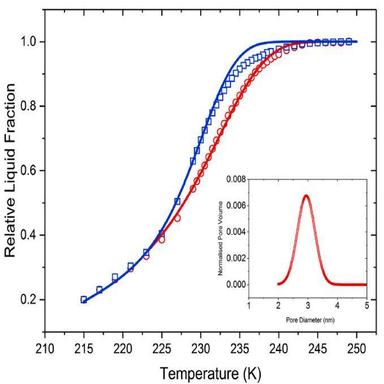
Melting (red circles) and freezing (blue rectangles) transitions for water in the MCM-41 material studied. The solid lines show the best fit of the seriallyconnected pore model with L = 1 (the independent pore model limit) and with the kernels of to both transitions. The inset shows the PSD resulting from the fit. (For interpretation of the references to colour in this figure legend, the reader is referred to the Web version of this article.)